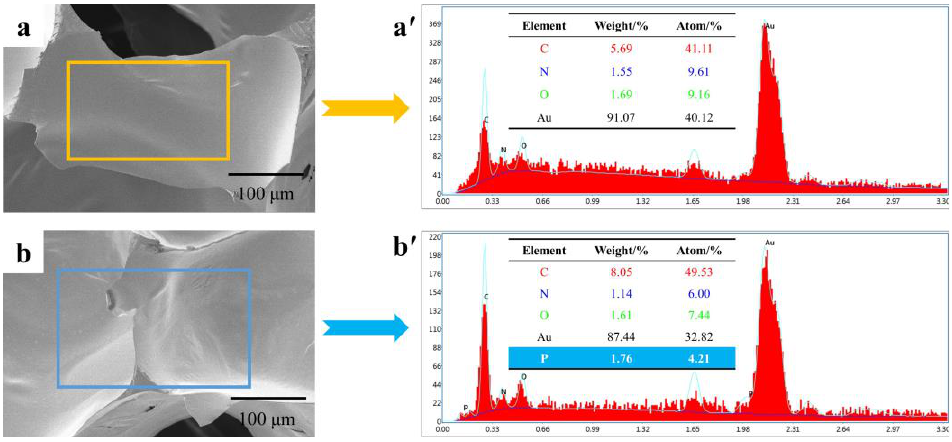
Figure 3. EDS results of RPIF-0-0 ( a , a′ ) and RPIF-0-10 ( b , b′ ).